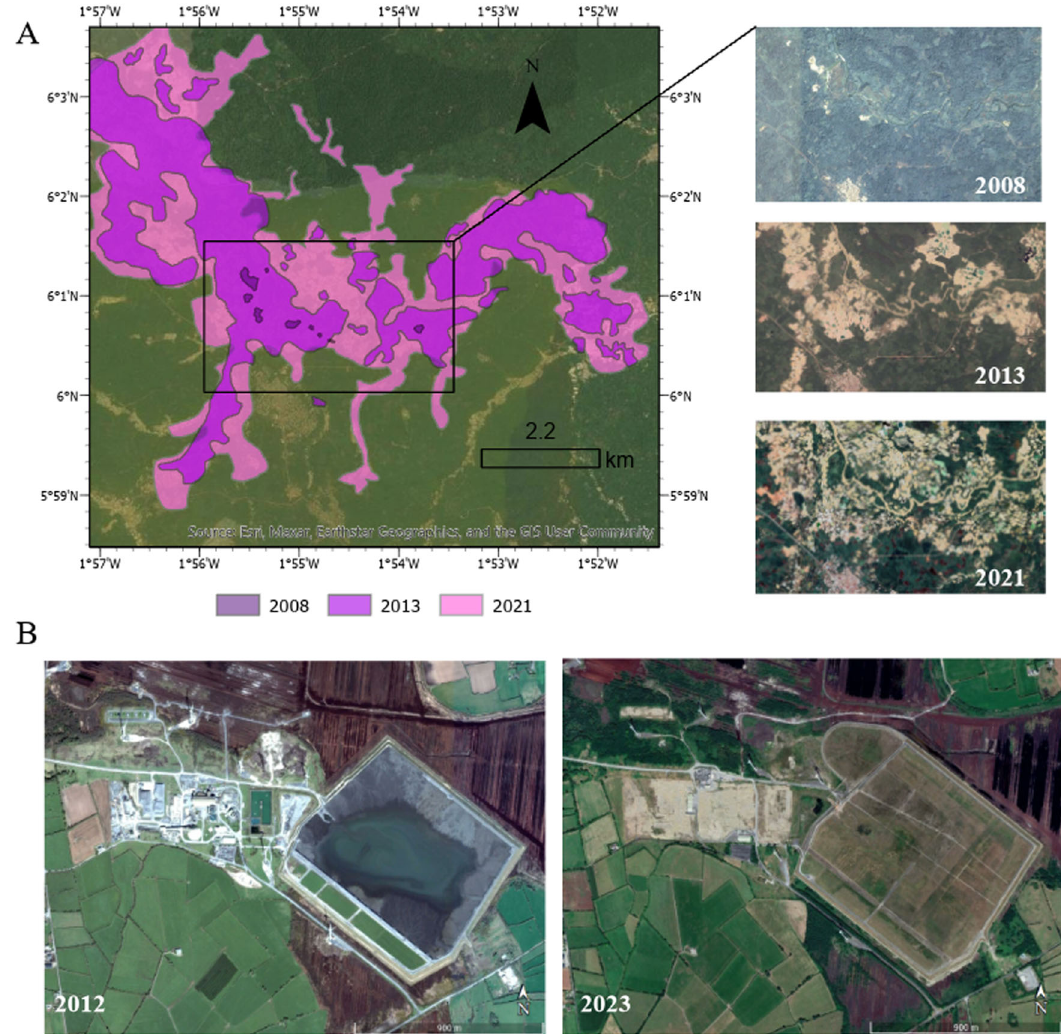
Fig. 5 The changing spatiotemporal characteristics of mine areas. A Spatiotemporal variation of ASM areas (placer gold mining, O fi n River, Ghana 6°1 ’ 00 ” N, 1°52 ’ 27 ” W). Image © 2023 CNES/Airbus and Maxar Technologies, visualized in Google Earth Pro. B Cessation mine tailings in the Lisheen Mine, Ireland. This mine was operational in 2012 and increasing vegetation cover is evident in 2023 (lead-zinc-silver mine; 52°45 ’ 01 ” N, 7°40 ’ 35 ” W). Images © 2023 CNES/Airbus, visualized in Google Earth